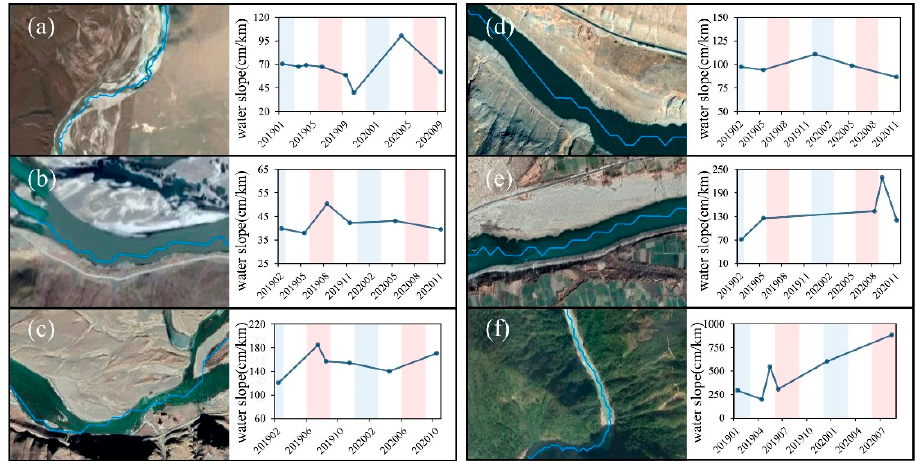
Figure 6. Changes in water surface slope of different river sections over the 2-year study period. ( a – f ) indicates the water surface slope for six different sections of the upper and middle reaches of the Yarlung Zangbo